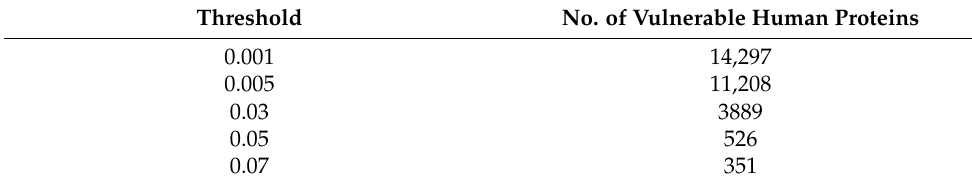
Table 9. Number of Vulnerable host proteins identified from the host–pathogen network for all selected coronavirus organisms at a different fuzzy threshold score.